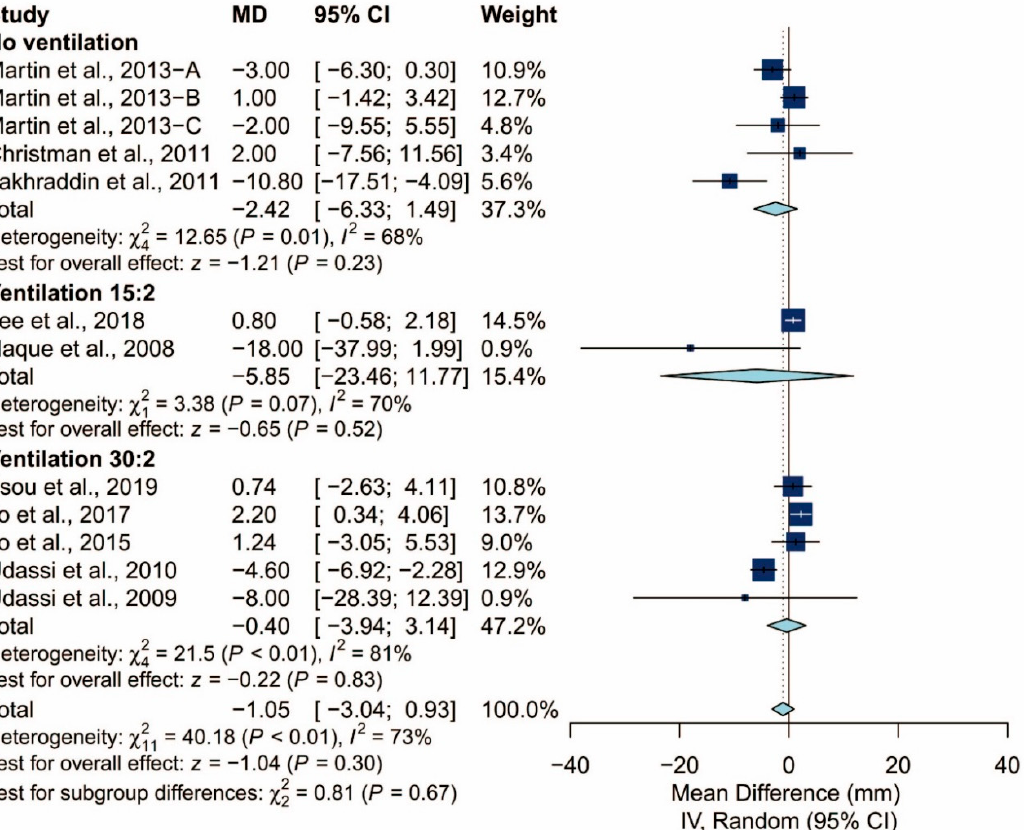
Figure 7. Subgroup analysis of chest compression rate grouped by ventilation protocol (yes/no).